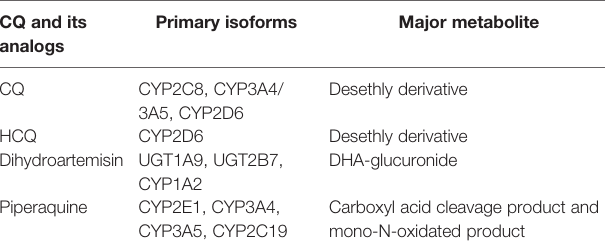
TABLE 3 | Pharmacogenomics of CQ and its analogs (Roos et al., 2002; Li J. et al., 2020).